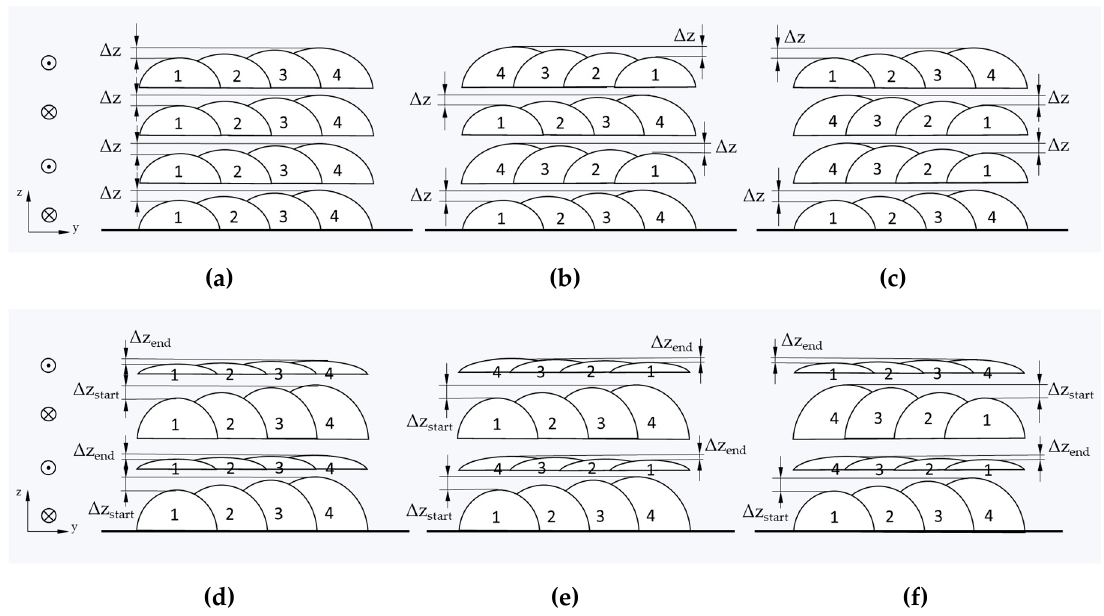
Figure 5. Path strategy for multitrack welds using the example of a 4-track weld; ( a ), ( b ), ( c ): effect of three different track sequences on the height evolution of the stationary region in the middle of the wall; ( d ), ( e ), ( f ): effect of the same sequences on the start-, respectively end region of the wall.